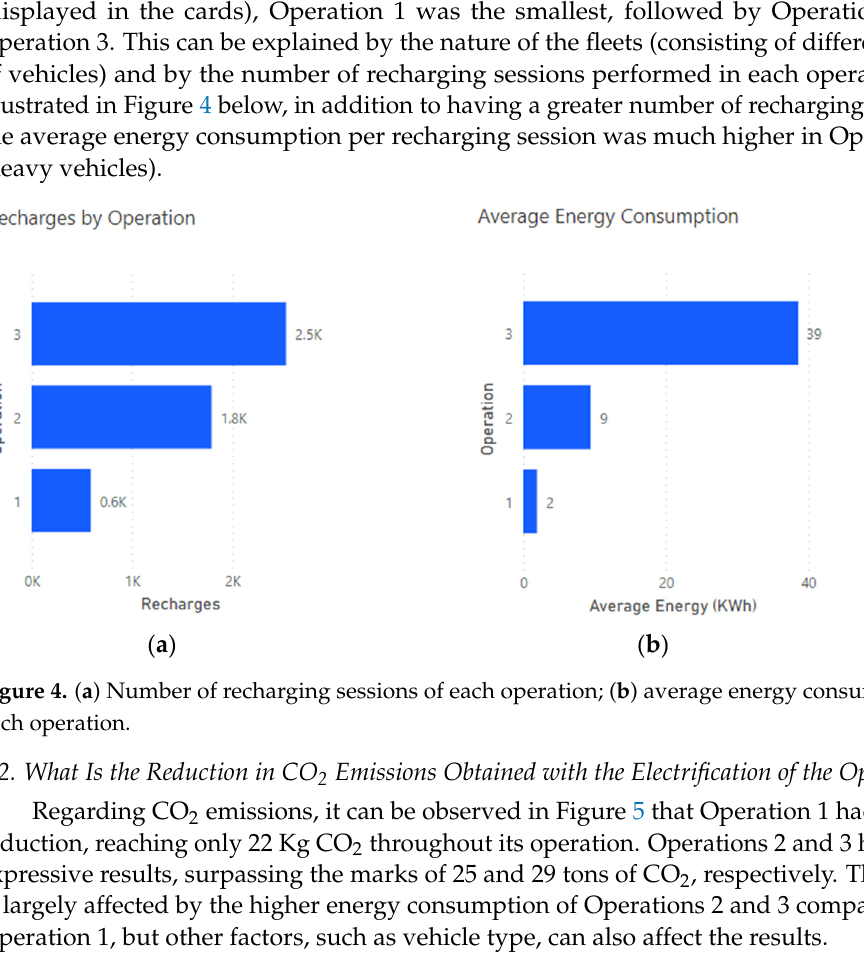
Figure 3. Energy consumption and costs of Operation 3 (heavy vehicles).